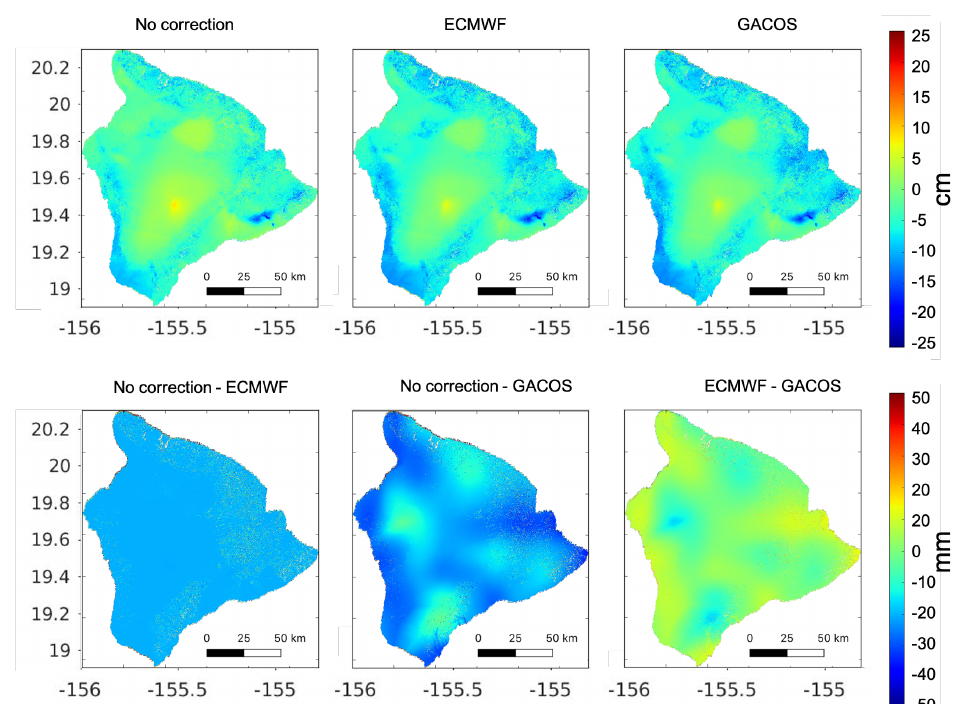
Figure 4. Top row: Cumulative displacement over the big island of Hawaii between January 2017 and June 2018 with no atmospheric correction applied ( left ), European Centre for Medium-Range Weather Forecasts (ECMWF) ( middle ) and Generic Atmospheric Correction Online Service (GACOS) ( right ) atmospheric correction applied. In the cumulative displacement plots, high (red) values mark an uplift, while low (blue) values mark subsidence. Bottom row: Differences between each of the cumulative displacement